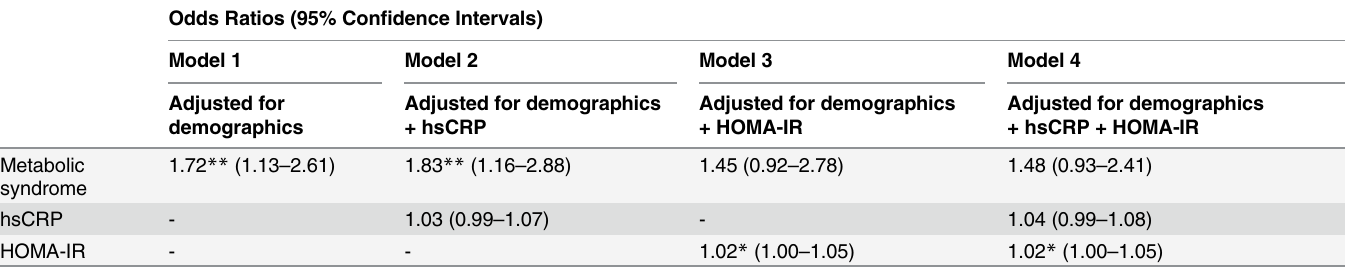
Table 3. Odds ratios for chronic kidney disease predicted by the metabolic syndrome with adjustments as described below.